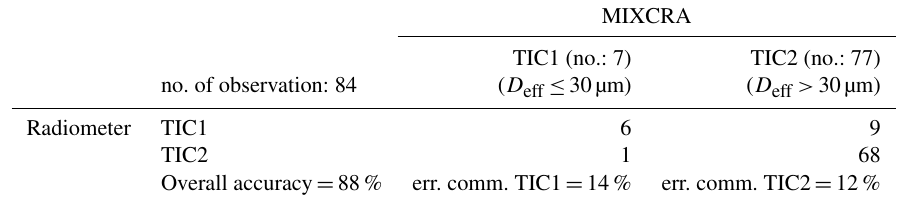
Table 4. Confusion matrix of the TIC1/TIC2 classification compared to MIXCRA retrievals. The term “err. comm.” stands for the error of